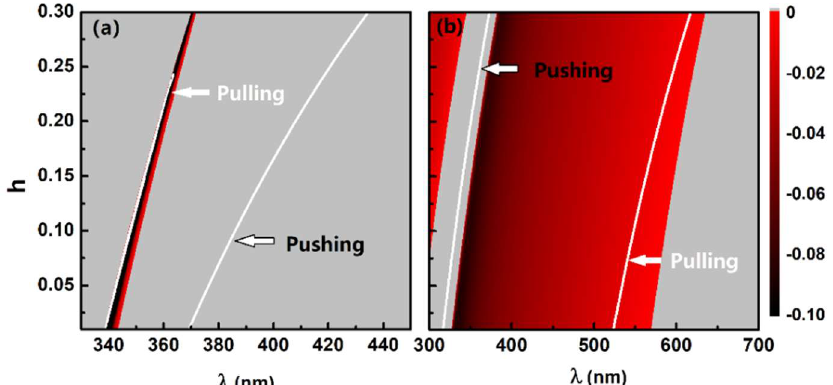
Figure 5. Im ( ε eq ) versus incident wavelength, λ , and gradient coefficient, h , for the cases of ( a ) low Im( )  versus incident wavelength,  , and gradient coefficient, h , for the cases of Figure 5. eq aspect ratio ( a / b = 0.2) and ( b ) high aspect ratio ( a / b = 0.8). Gray regions indicate the parameter ( a ) low aspect ratio ( / 0.2 a b  ) and ( b ) high aspect ratio ( / 0.8 a b  ). Gray regions indicate the space for a positive value. The white lines show the positions of Re ( ε eq ) = − 2 ε h . The gain coefficient Re( ) 2    . The parameter space for a positive value. The white lines show the positions of is set as ε cg = − 0.07 for both eq h 0.07    for both cases. gain coefficient is set as cg